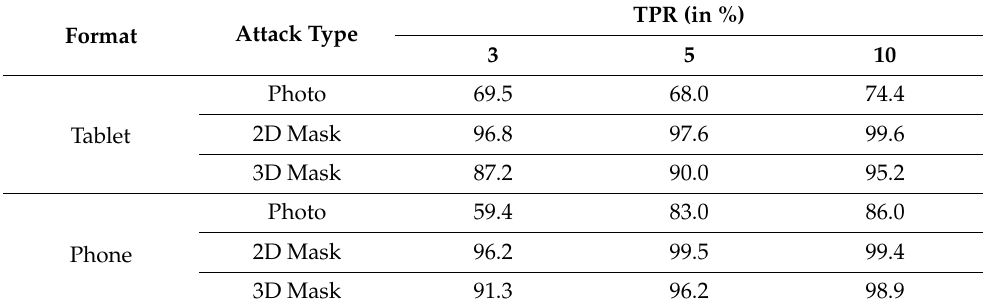
Table 4. TPR at FPR = 0.10 for various challenge duration (in sec.) (trajectory: Curve